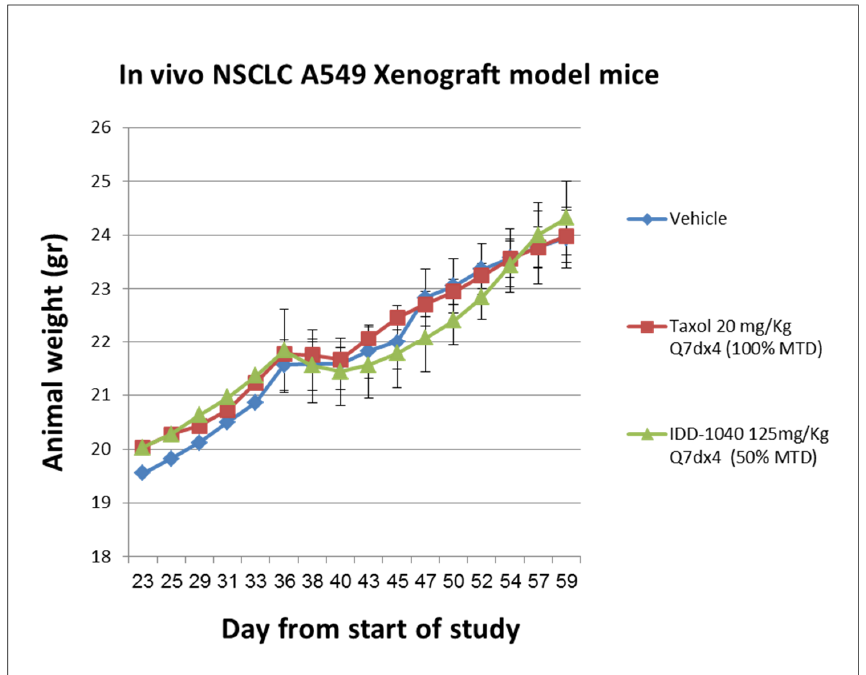
Figure 6. Animal body weight curves following the IV administration of IDD-1040, Taxol (paclitaxel), and vehicle in an in vivo A549 NSCLC xenograft study in mice. Animals were treated with vehicle, paclitaxel (PTX, at 100% of the maximum tolerated dose (MTD)), and IDD-1040 (at 50% of the MTD) administered weekly for four weeks.